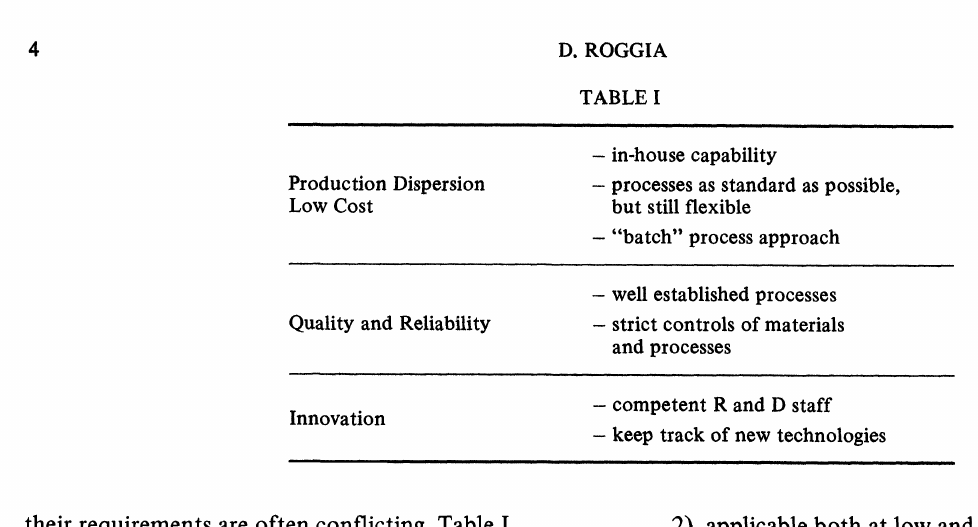
in-house capability processes as standard as possible, but still